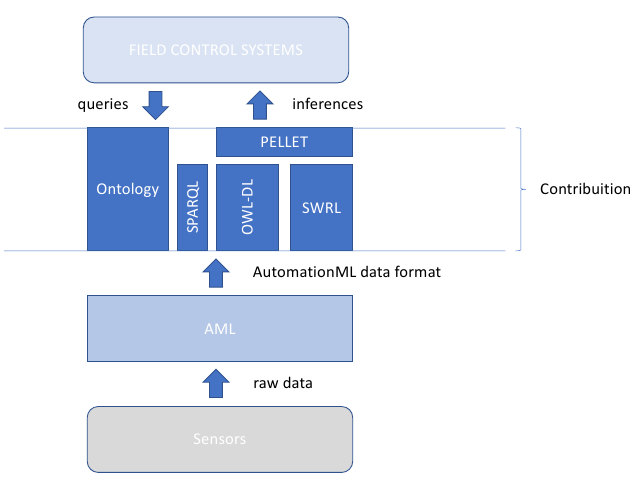
Figure 3. Ontology description.